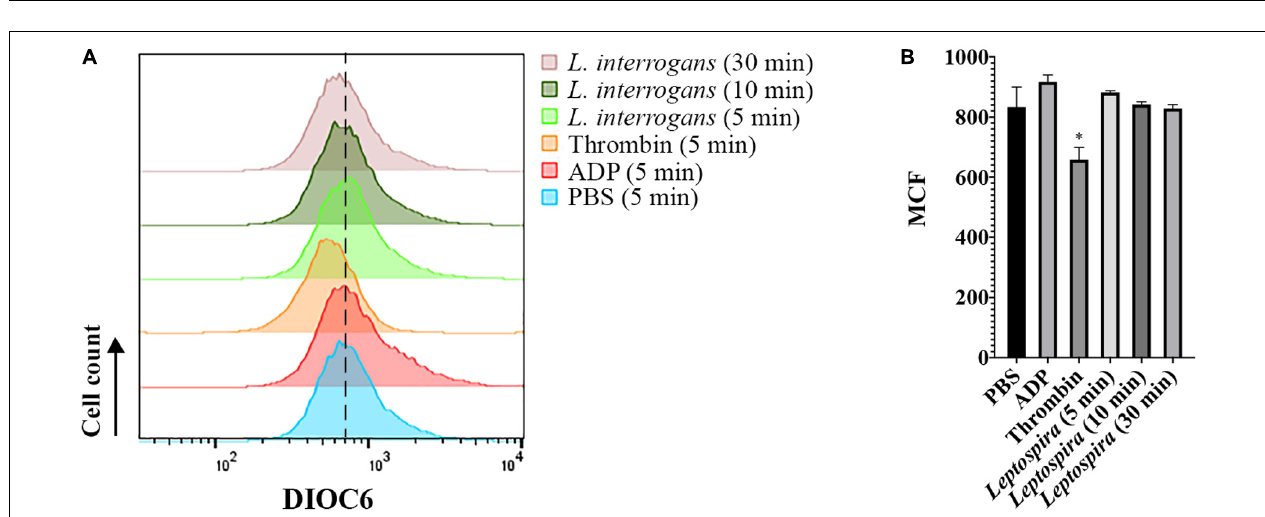
FIGURE 7 | Flow cytometry analysis of platelet mitochondrial transmembrane potential after different stimuli. Platelets in PRP were incubated with the addition of PBS (negative control), ADP, thrombin, or virulent leptospires (2 × 10 6 /mL) for 5, 10, or 30 min, with the addition of the fluorescent dye DIOC6(3). Platelets were marked with CD41a-APC and the results represent only the platelet gate. (A) histogram of the DIOC6(3) detection on the CD41a-positive gate. The dashed line was included to aid in the interpretation of the histogram displacement. Data are representative of four independent experiments, with four different healthy blood donors. (B) Mean Channel Intensity (MCF) of each different sample. The bars represent the mean ± standard deviation of two independent experiments. For each sample, 20,000 events were collected. One-way ANOVA analysis was performed to compare the different samples with the negative control (PBS). * P > 0.0002.